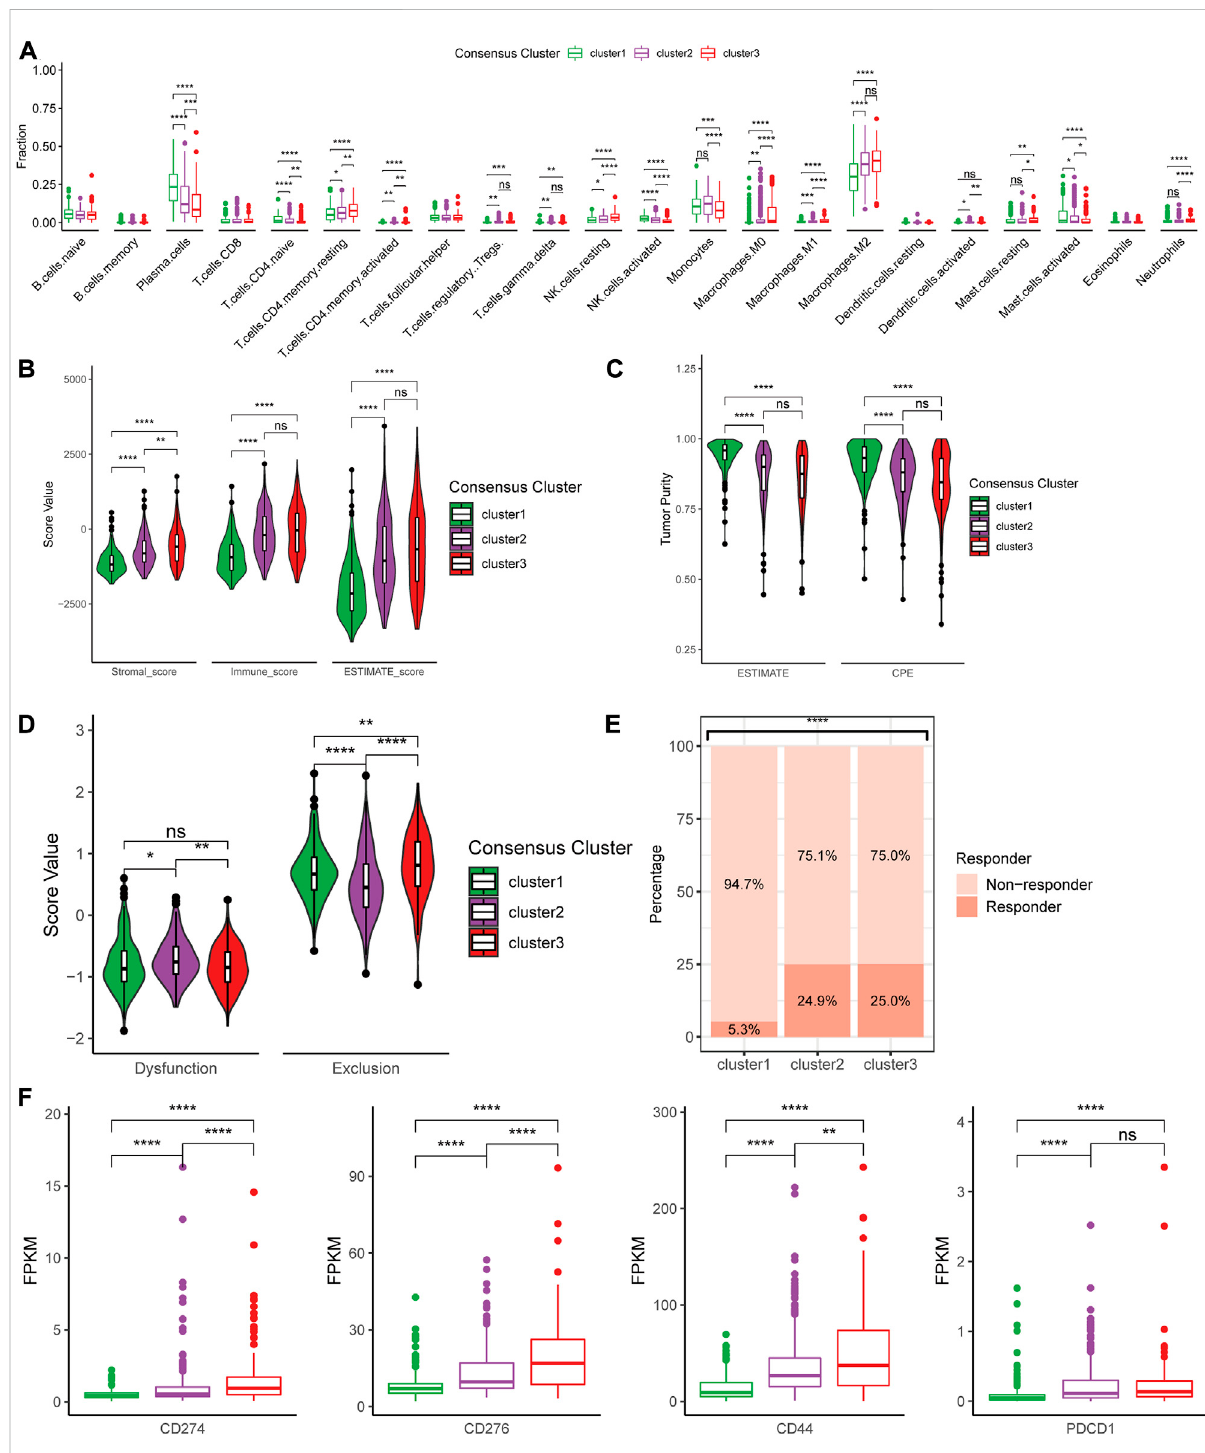
FIGURE 5 Differences in immune features of tumor microenvironment between the clusters. (A) Boxplot of the estimated fraction of 22 immune cells in tumors. (B) Stromal, immune, and ESTIMATE scores of the consensus clusters. (C) Tumor purity is calculated by the ESTIMATE and CPE algorithms. (D) T cell dysfunction and exclusion score of the consensus clusters. (E) Percentage of predicted responder to immunecheckpoint inhibitor therapy in each consensus cluster. (F) The expressionlevel of 33 immunotherapy-related genes ineach consensus cluster. * p < 0.05; ** p < 0.01; *** p < 0.001; **** p < 0.0001, post hoc Wilcoxon test results were shown if p < 0.05 in Kruskal – Wallis